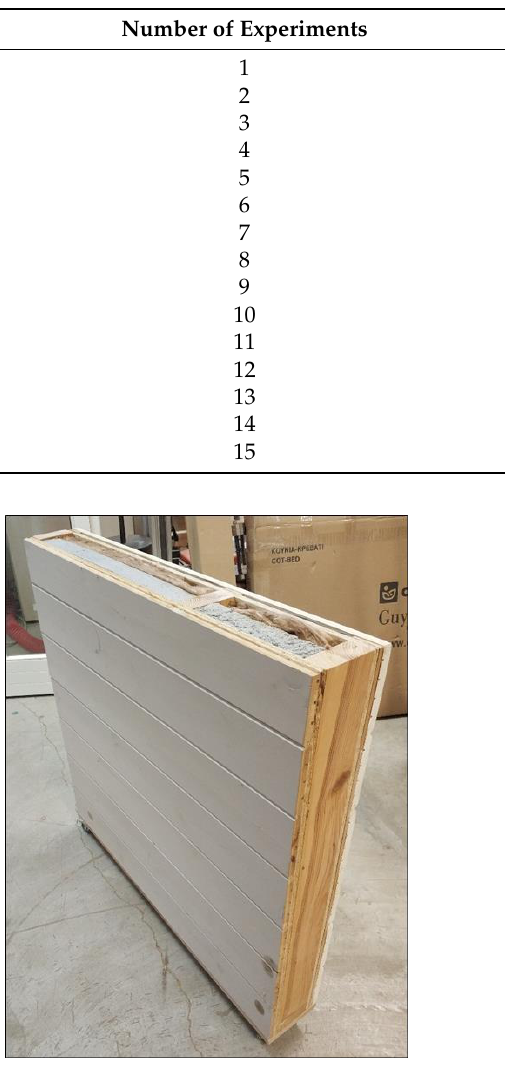
Table 2. Combination of insulating materials.